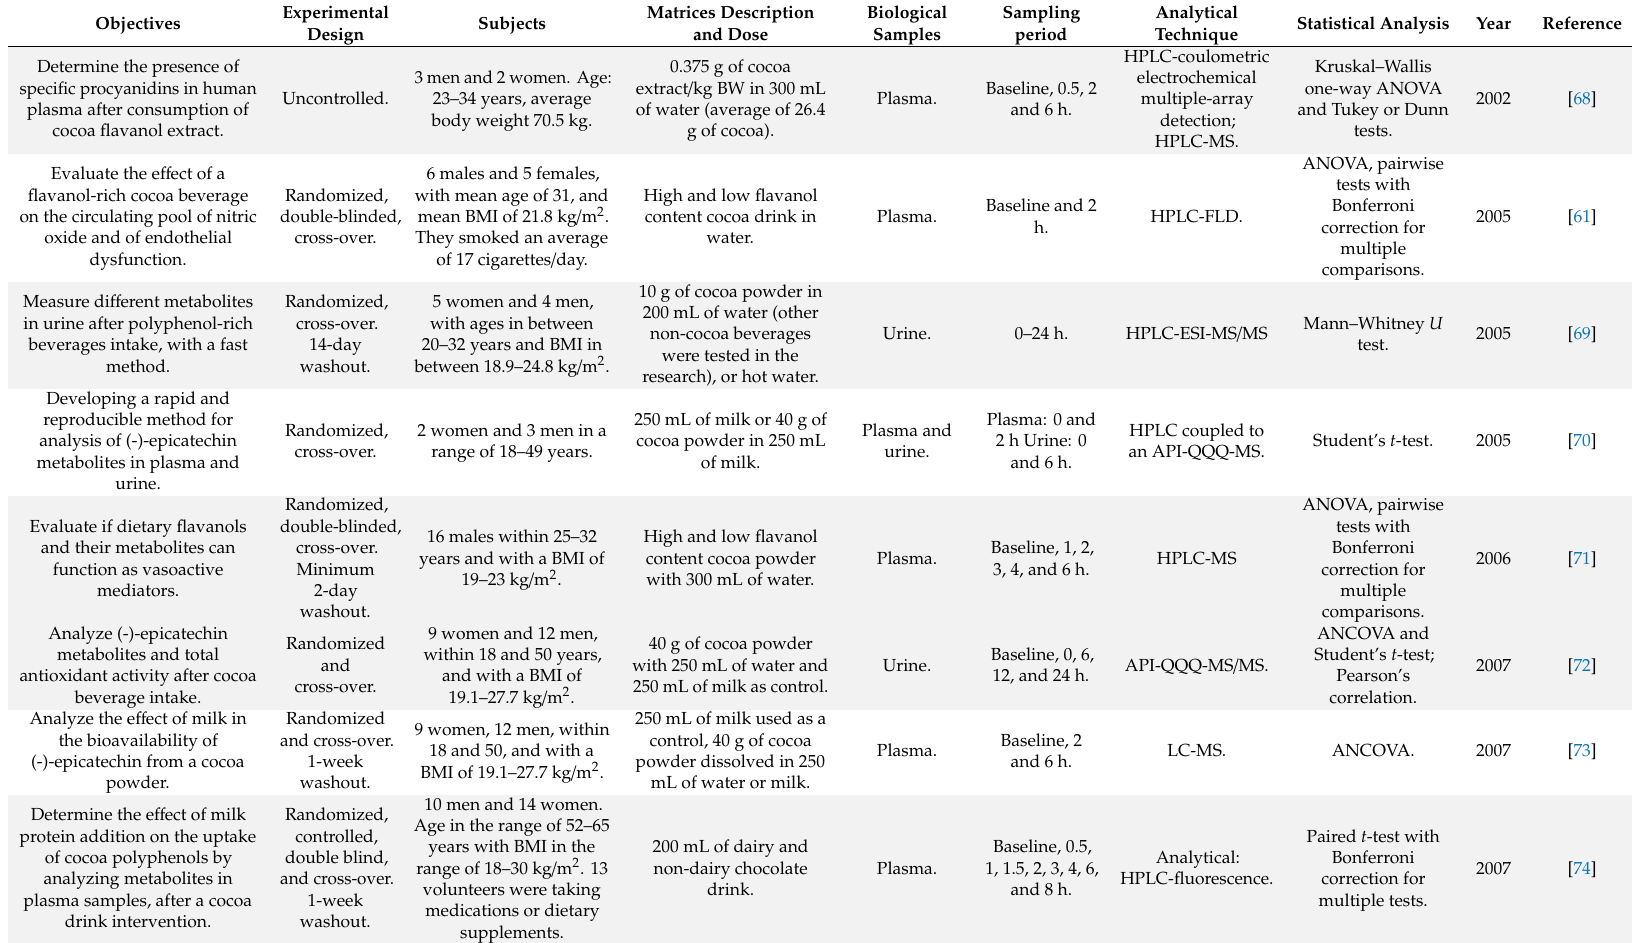
Table 2. Summary of the main aspects of targeted cocoa studies, involving cocoa powder or cocoa extracts-based drinks